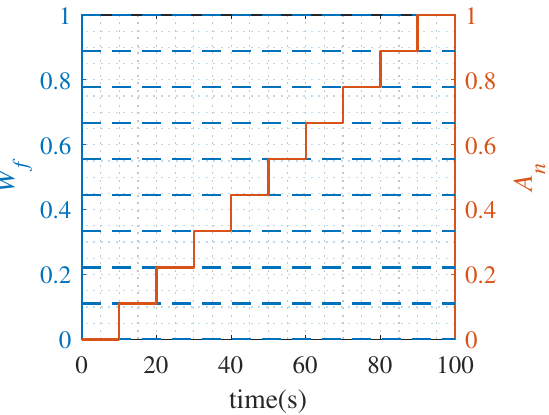
Figure 1. The input variables W f and A n for the simulation of the NCL model.